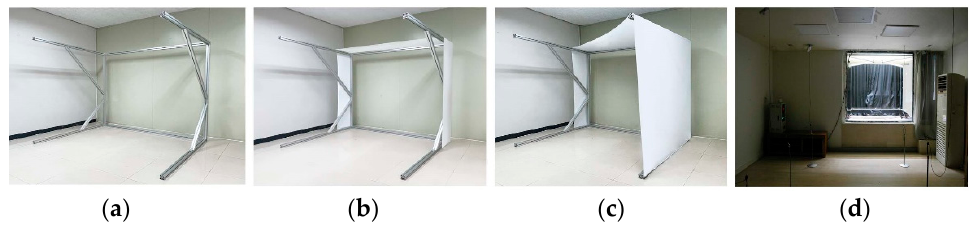
Figure 6. Test specimens for performance evaluation: ( a ) fabrication of moving parts (profile), ( b ) awing installation, ( c ) awning control, and ( d ) installation in the test bed.